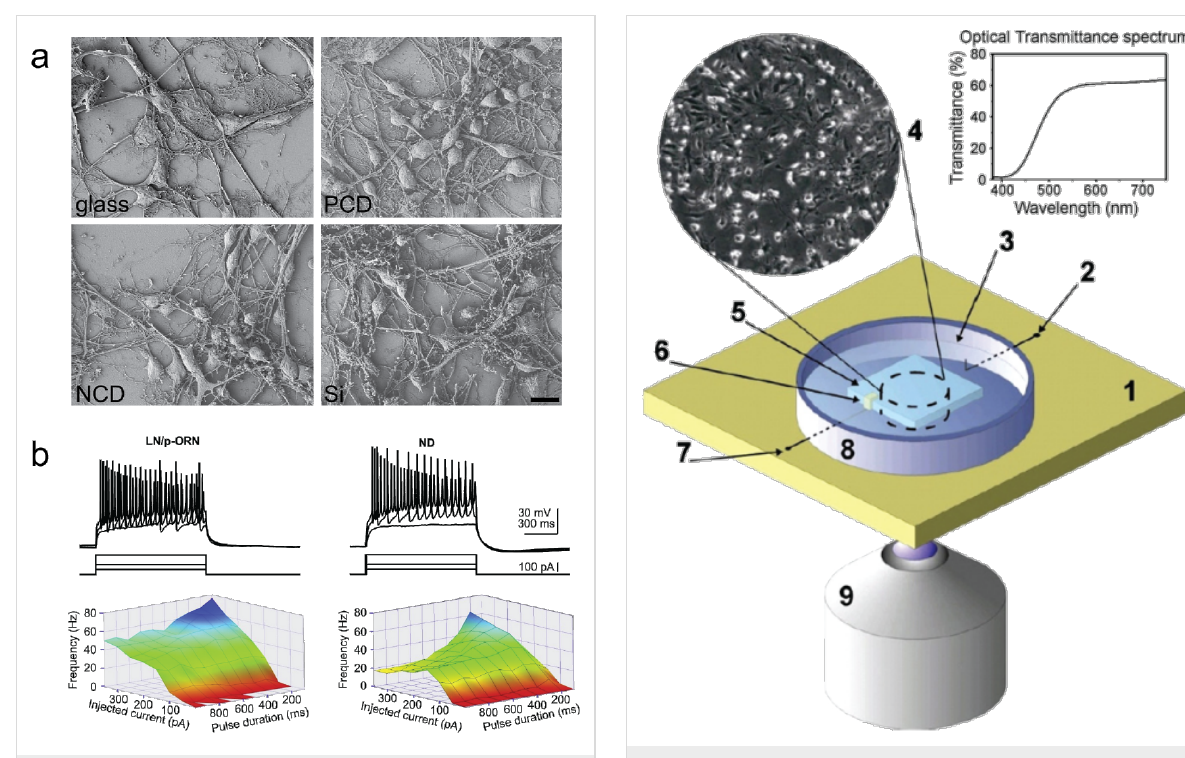
Figure 4: Scanning electron micrographs show that, when exposed to animal blood serum proteins, polycrystalline (PCD) and nanocrystal- line diamond (NCD) substrates performed as good as glass or silicon substrates (a). NDs coating did not alter single-cell excitability (b). Reproduced and modified from [130] with permission. Copyright 2010 Elsevier.